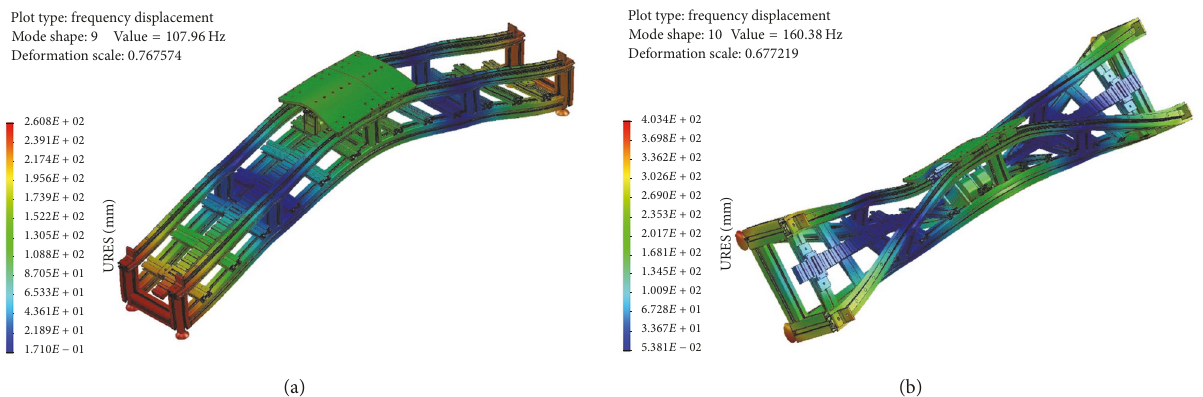
Figure 12: Modal shapes at P3 for: (a) mode 9 ( 𝑓 ≈ 108 Hz, def. scale ≈ 0.767), one node at the central region; (b) mode 10 ( 𝑓 ≈ 161Hz, def. scale ≈ 0.677) with two nodes almost